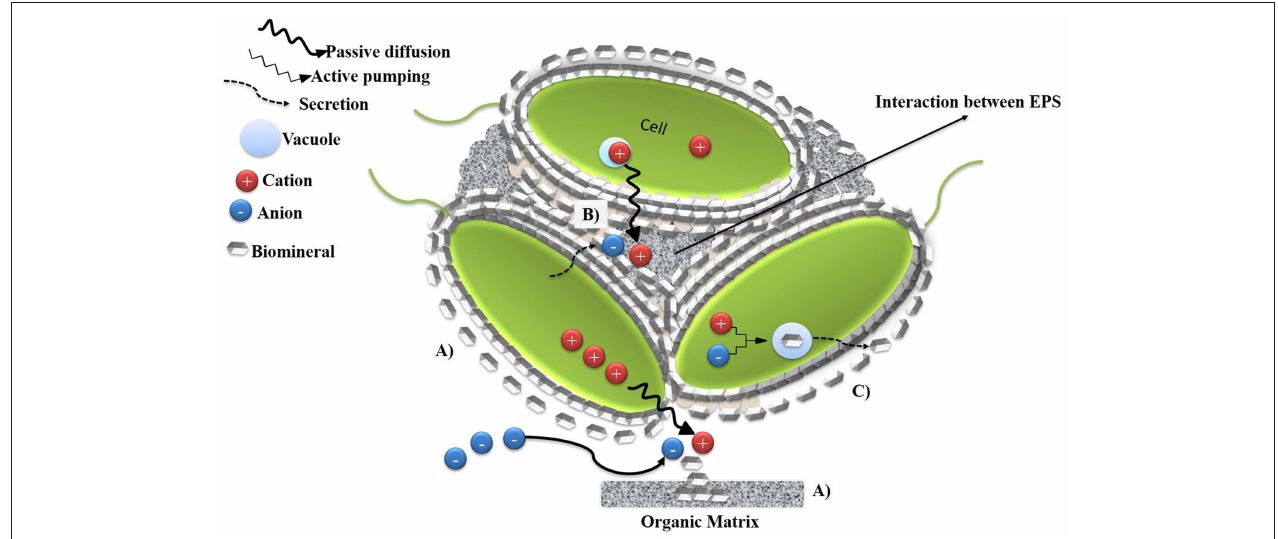
FIGURE 1 | Schematic representation of Biologically Controlled Mineralization (BCM). (A) BCMe, nucleation of minerals occurs in organic matrix by passive diffusion of cations out of the cell. (B) BCMint, epithelial surfaces of the cells serve as organic substratum and they orient and shape the precipitation of biominerals around the surface (C) BCMin, the biomineral is formed in a specialized vesicle within the cells and subsequently is secreted. Adapted from Weiner and Dove (2003).